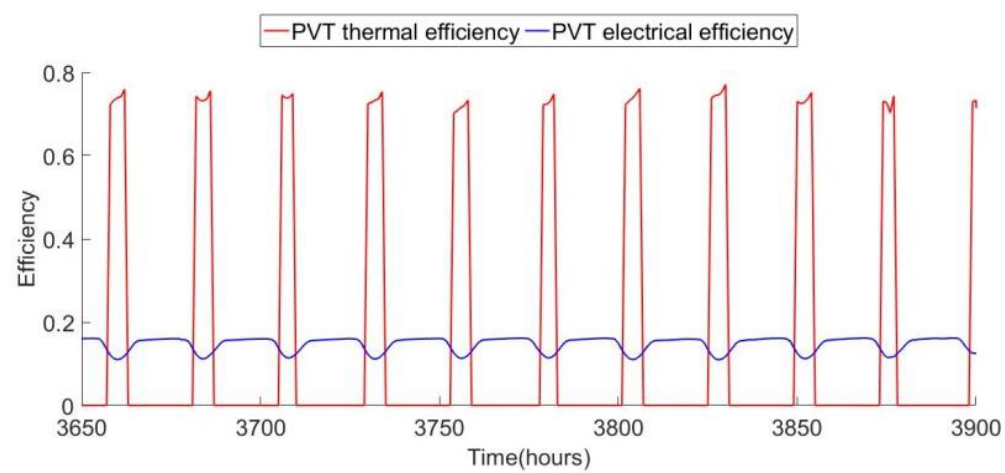
Figure 10. Hourly variations in PVT thermal and electric efficiency.